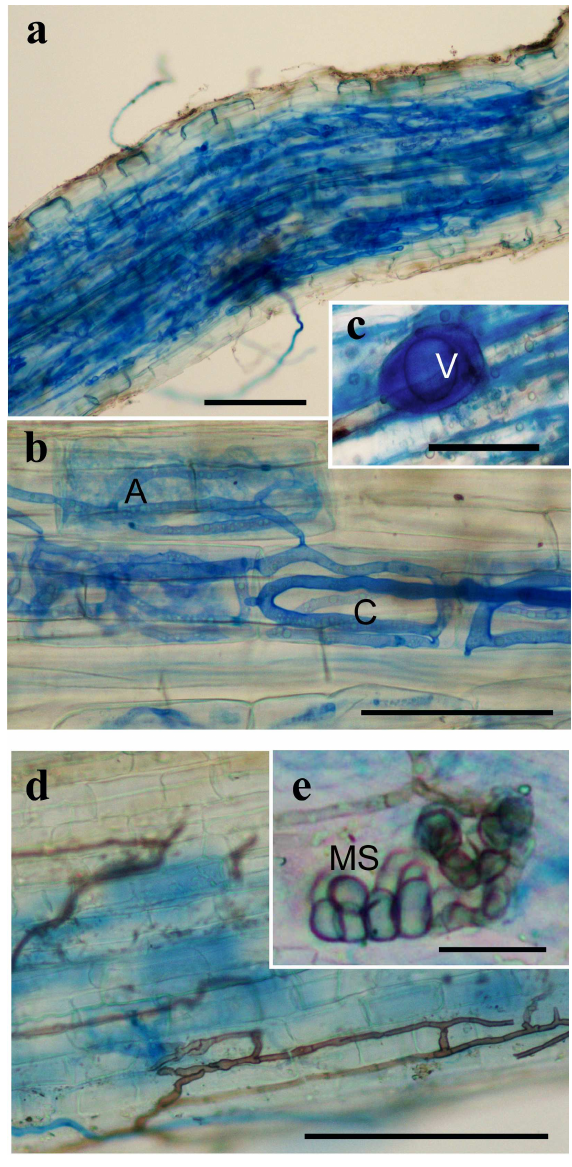
Fig 1. Representative images of B . subacaulis roots colonized by arbuscular mycorrhizal fungi (AMF, a-c) and dark septate endophytes (DSE, d-e) . (a) Extensive AMF colonization; (b) arbuscules (A) and intracellular hyphalcoils (C); (c) intercellularvesicle (V); (d) DSE hyphaegrowingon the root epidermisand insidethe cortex; (e) microsclerotium (MS); a, bar = 500 μ m; b-d, bar = 100 μ m; e, bar = 20 μ